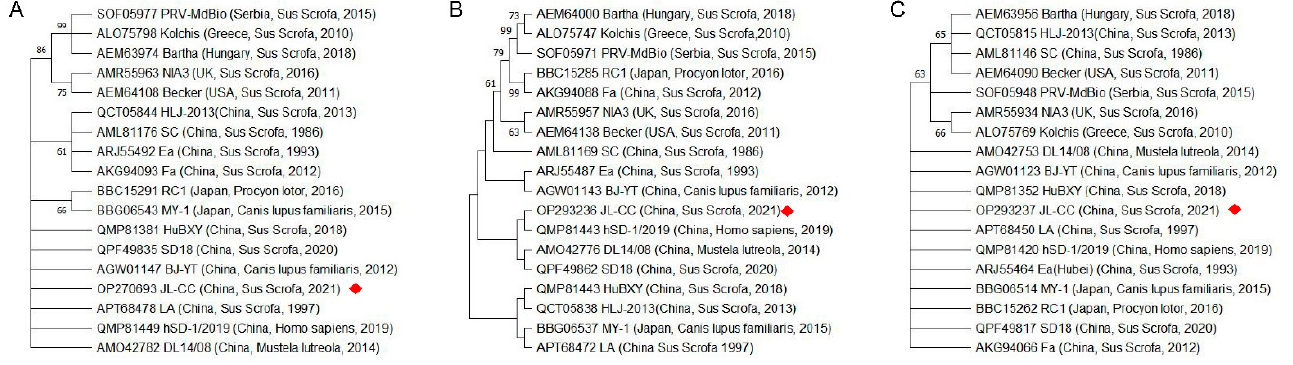
Figure 1. Phylogenetic tree based on the amino acid sequences of PRV. ( A ) gD, ( B ) gL, ( C ) TK. The red diamond indicates the PRV JL-CC strain, which was previously isolated from Jilin province, China [1]. The year, country, and host of isolates are indicated in the brackets. Table 1. Mutations in gD, gL, and TK proteins of PRV hSD-1 2019 and JL-CC strains compared with that of the Bartha